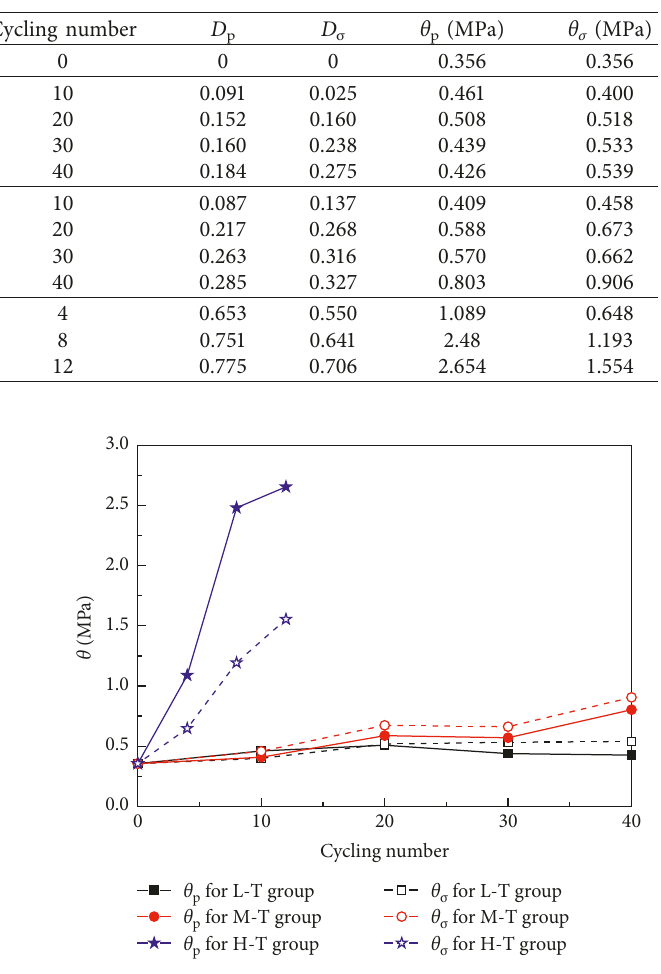
Table 3: Test results on damage of sandstone after H-C cycles.